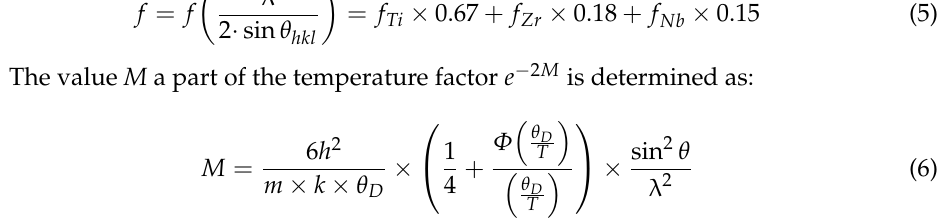
110 4 · f 2 200 211 4 · f 2 220 4 · f 2 310 4 · f 2 222